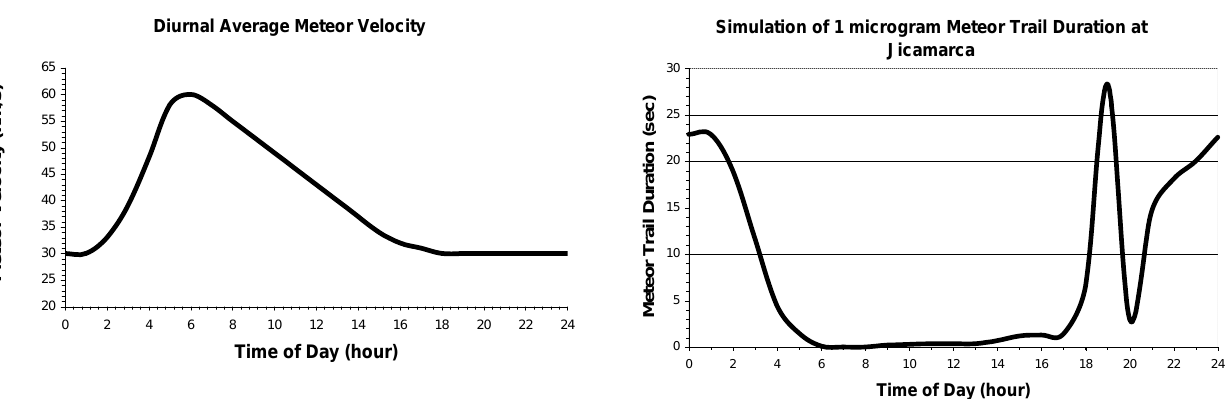
Figure 7. Simplified model of the nominal diurnal variation of micrometeoroid velocity used in the 24 hour simulation presented in Figure 8. Note that a night time meteor velocity of about 30 km/s is a near